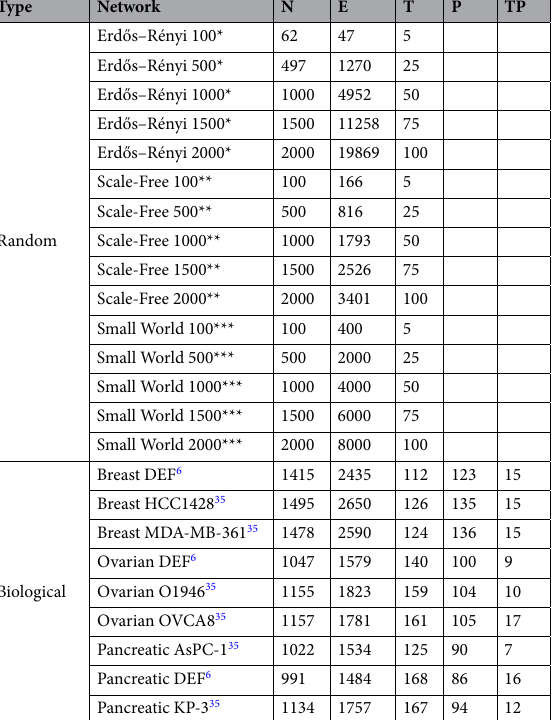
Table 1. The analyzed data sets. All isolated nodes were removed from the networks. N Number of nodes in the network, E number of edges in the network, T number of control target nodes in the network, P number of preferred (i.e., drug-targetable) nodes in the network, TP number of control target nodes in the network that are also preferred (i.e., drug-targetable) nodes. *,**,***Generated using “networkx” 34 , *: “fast_gnp_random_ graph” with p = 0.005 ), **: “scale_free_graph” with the default parameters, ***: “watts_strogatz_graph” with k = 4 and p = 0.2